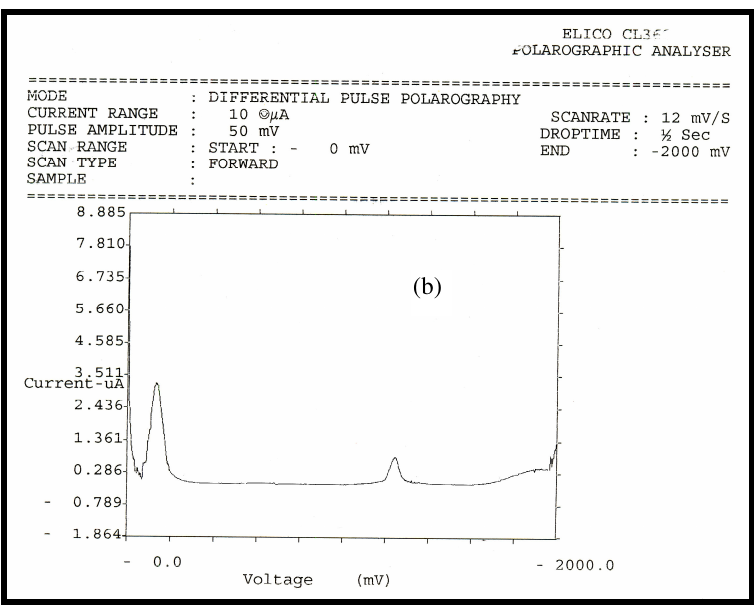
Figure 2. (a) Direct current polarogram of modified paracetamol ( n -methyl paracetamol) in Britton Robinson buffer (1 M) at pH 7.2±0.1;(b) Different pulse polarogram of modified paracetamol ( n -methyl paracetamol) in Britton Robinson (1 M) at pH